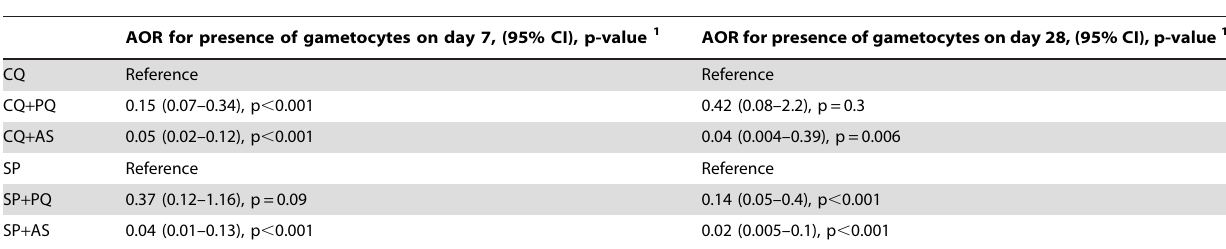
Table 8. Effect of treatment on gametocyte carriage at day 7 and day 28, for those patients who were gametocytaemic on